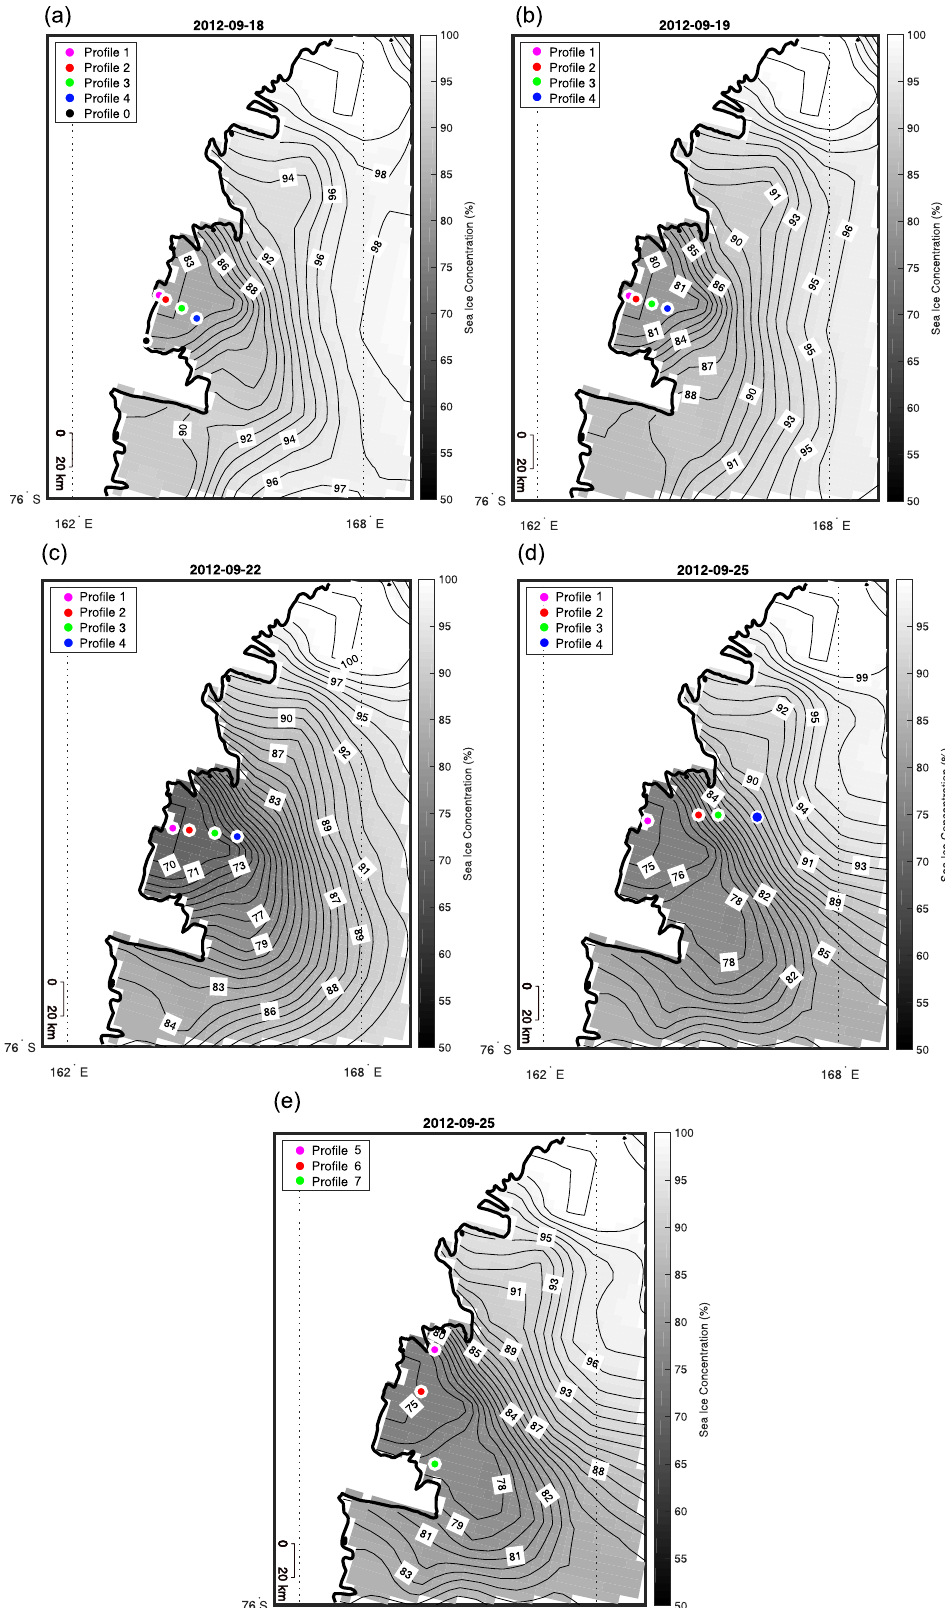
Figure 11. Location of the UAS Aerosonde profiles with maps of AMPS sea ice concentration for profiles 1–4 from 18, 19, 22, 25 September 2012 ( a – d ) and profile 5-7 from 25 September 2012 ( e